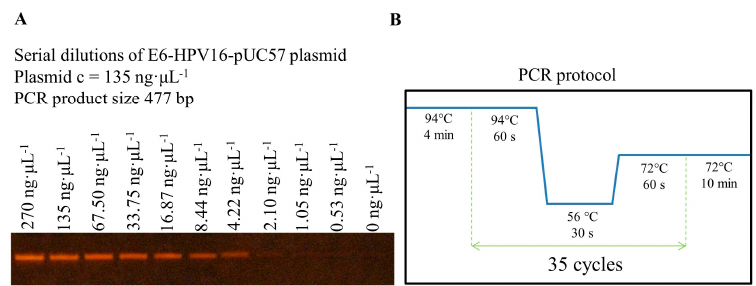
Figure 3. Optimization of template E6-HPV16-pUC57 plasmid concentration and scheme of standard PCR conditions: ( A ) finding the optimal concentration of DNA template for polymerase chain reaction (PCR); and ( B ) PCR protocol.